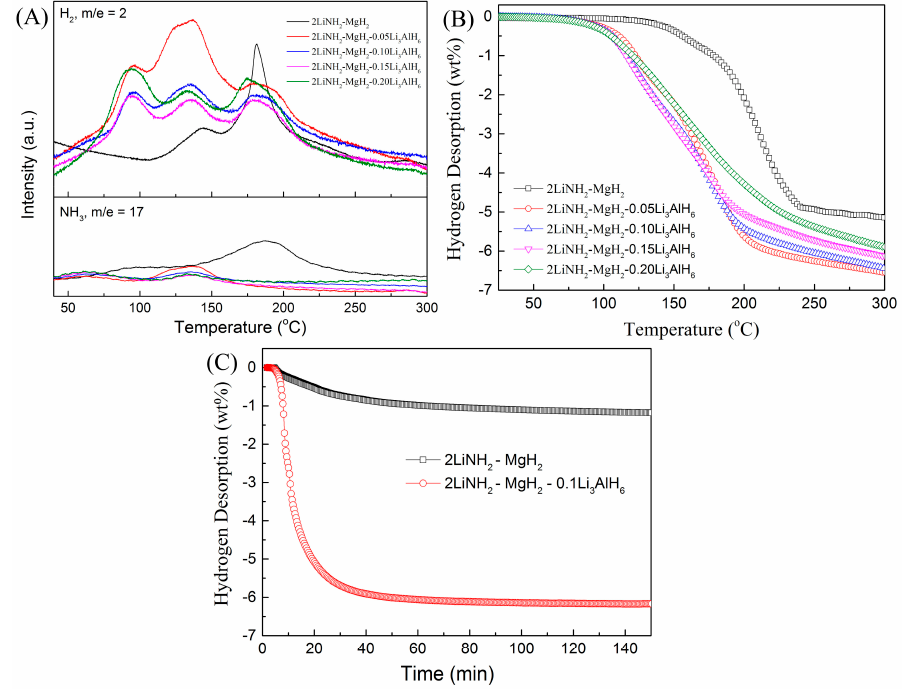
Figure 2. ( A ) Temperature ‐ dependent gas (hydrogen (top) and ammonia (bottom)) released and ( B ) non ‐ isothermal dehydrogenation curves of 2LiNH 2 ‐ MgH 2 ‐ XLi 3 AlH 6 samples; ( C ) Isothermal dehydrogenation curves of 2LiNH 2 ‐ MgH 2 and 2LiNH 2 ‐ MgH 2 ‐ 0.1Li 3 AlH 6 at 160 °C.